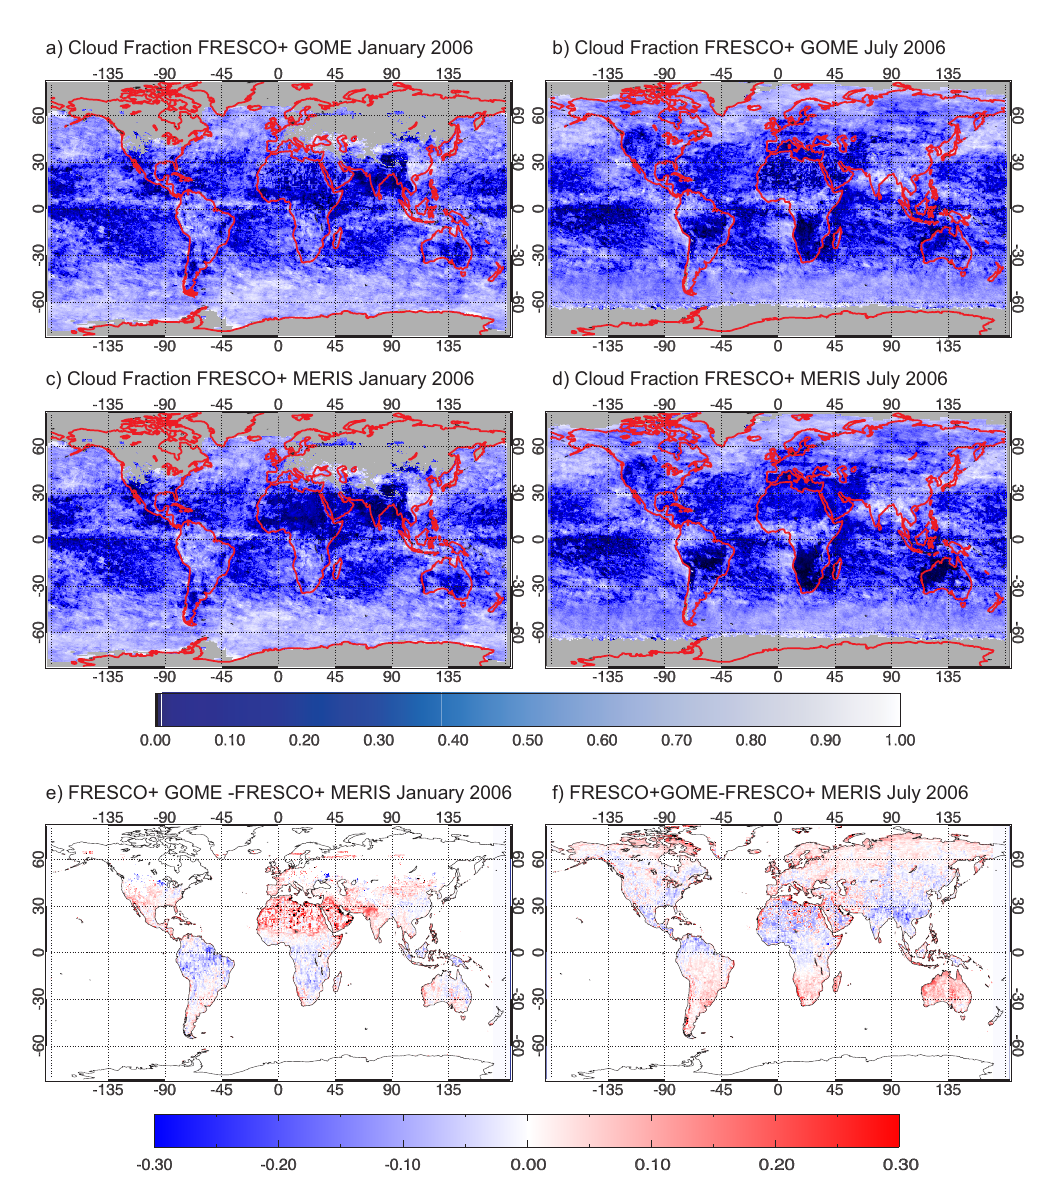
Fig. 5. Monthly mean FRESCO+GOME and FRESCO+MERIS effective cloud fraction (a–d) as well as their absolute differences (e–f) for January and July 2006. Note that ocean pixels are processed with the GOME LER data also in the MERIS retrieval so that no differences occur over water. Grid cells with no valid retrieval, e.g. due to permanent snow coverage are given in a grey